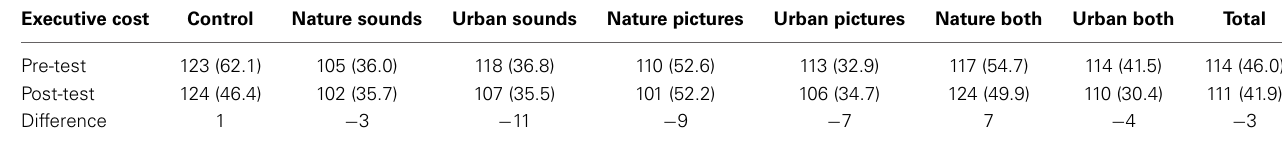
Table 4 | Scores from the Attention Network Task (ANT) executive component, for all conditions. Executive